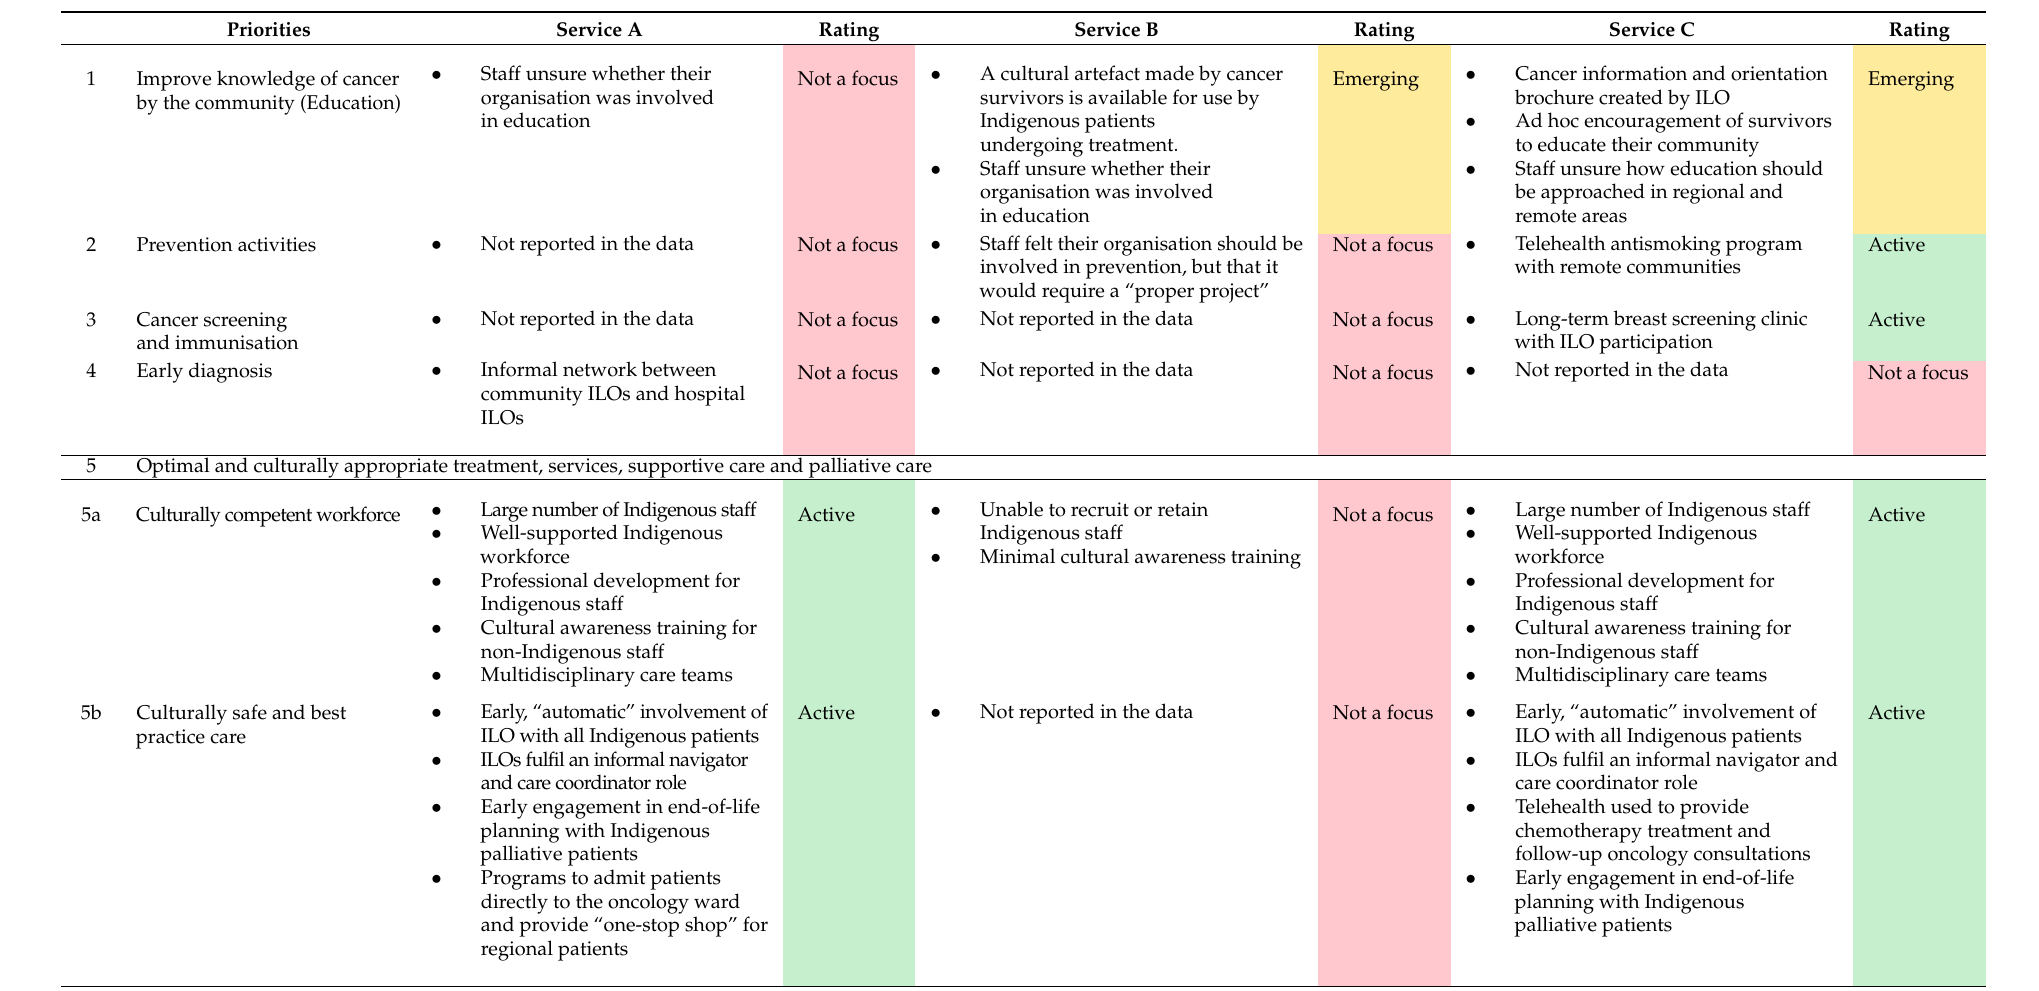
Table 1. Cancer service performance scored against the National Aboriginal and Torres Strait Islander Cancer Framework priorities using traffic light rating